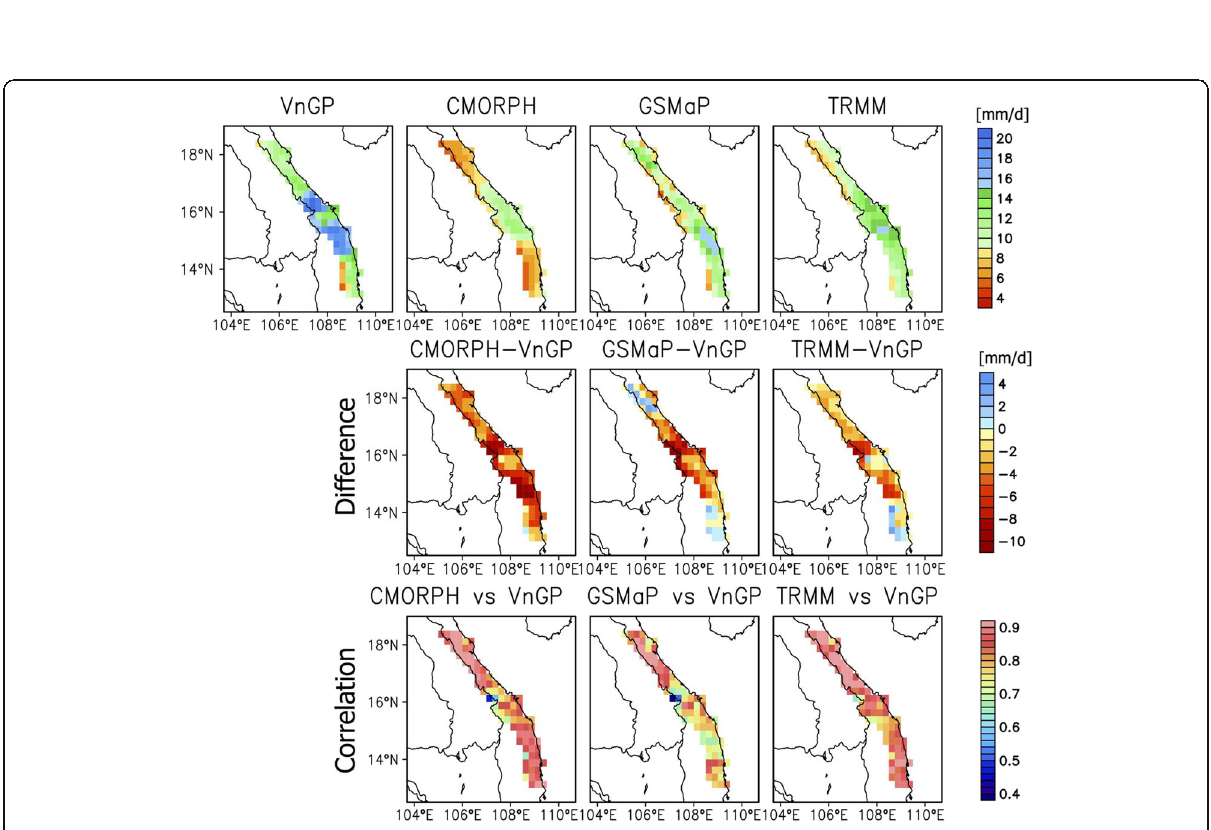
Fig. 8 Same as Fig. 5, except for SOND rainfall over the